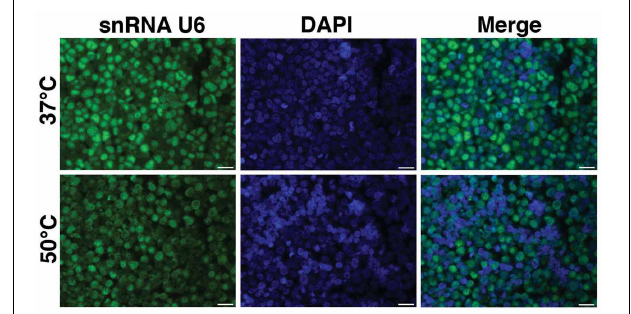
FIGURE 1 | Optimization of hybridization temperature. FISH was performed for snRNA U6 in FFPE sections of BE(2)M17 cells. Two hybridization temperatures were compared. The snRNA U6 signal (green) appeared to be brighter in the sections that were hybridized at 37 ◦ C (top panel) compared to those that were hybridized at 50 ◦ C (bottom panel). Scale bars are 20 µ m.